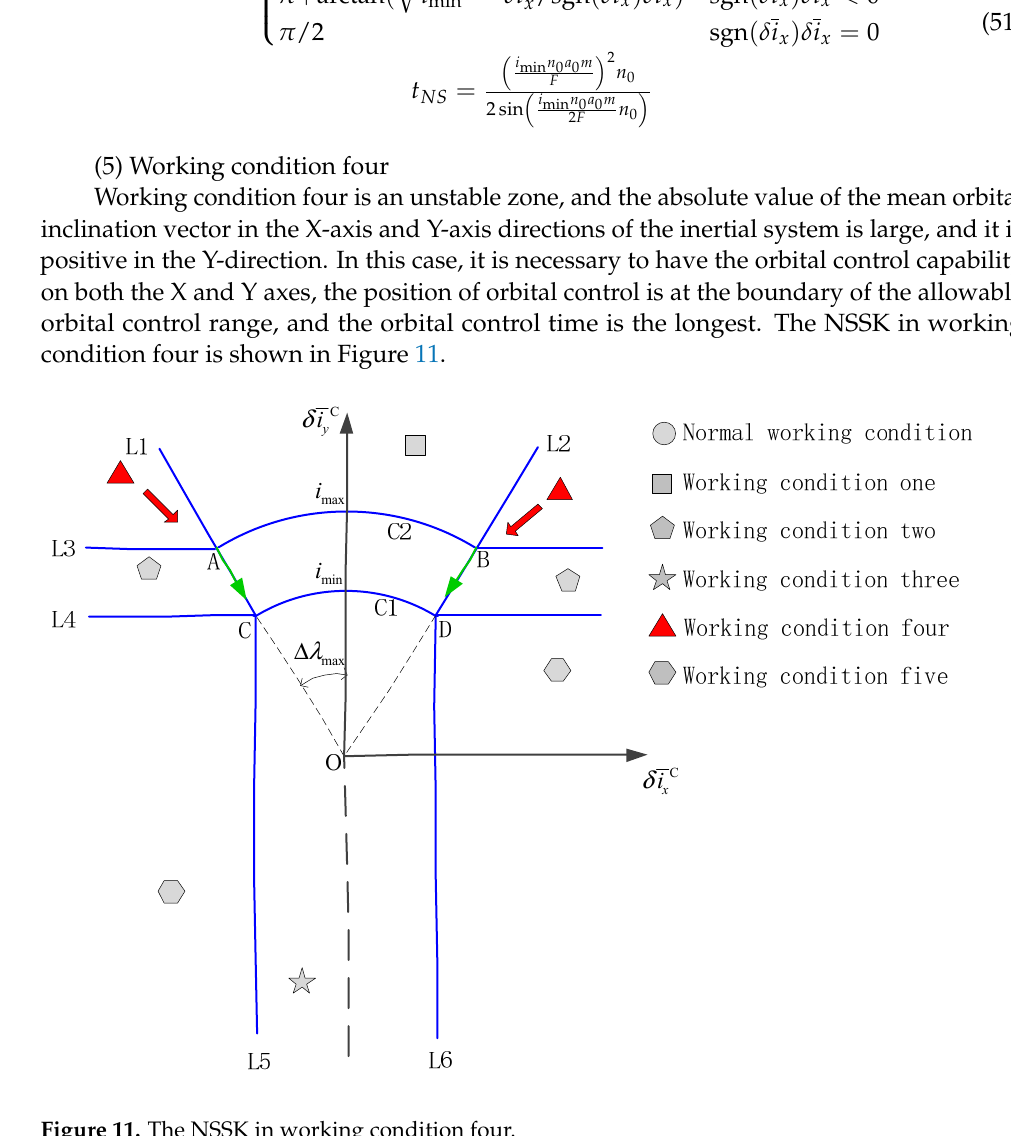
Figure 11. The NSSK in working condition four. In Figure 11, the starting point of the straight line arrow is located at A or B on the C2 circle, indicating that the duration of the orbital control is longest. The straight arrow points in the direction of AC or BD, indicating that the orbital position is constant in the inertial frame. The 45 ◦ arrow describes the approximate movement direction of the orbital inclination vector under the combined action of the perturbation force and the control force of the SK. Since the orbital control duration remains constant, if the rate of change of the mean orbital inclination vector caused by the environmental perturbation force is also regarded as a constant value, then under the action of the orbital control force and the natural perturbation force, the mean orbital inclination vector will move in a fixed direction. Because the control force of the inclination vector in both directions is greater than the natural perturbation force, the working condition four will theoretically enter